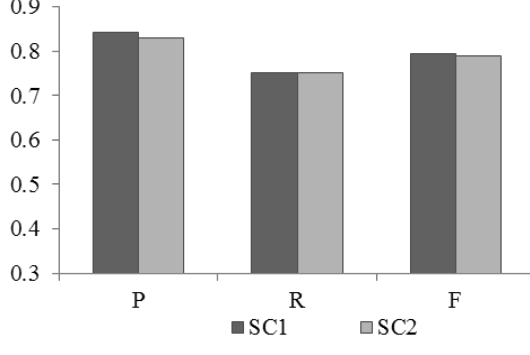
Fig. 7. Semantic code research on product reviews